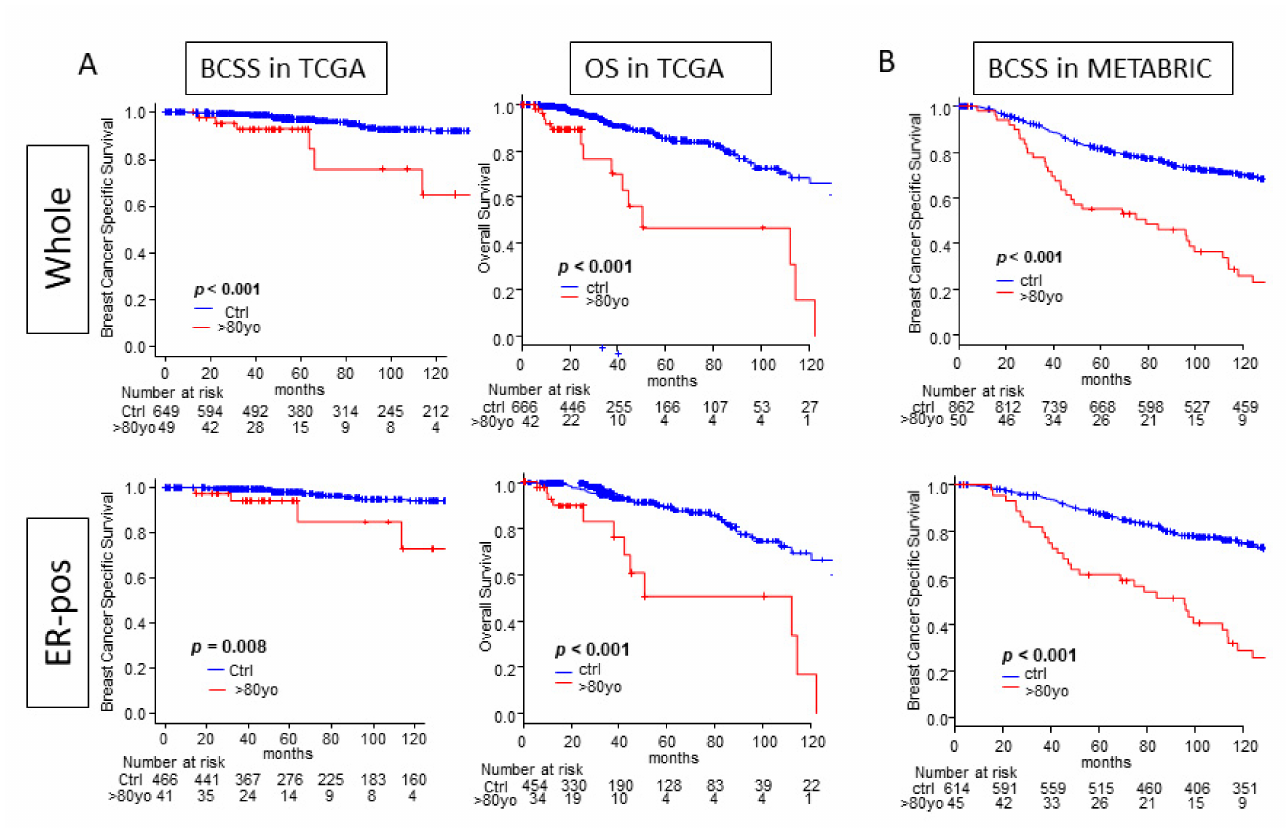
Figure 2. Survival analyses. ( A ) Kaplan–Meier survival curves for breast cancer specific survival (BCSS) and overall survival (OS) between the octogenarian group and the control group in the TCGA cohort. ( B ) Kaplan–Meier survival curves for BCSS between the octogenarian group and the control group in the METABRIC